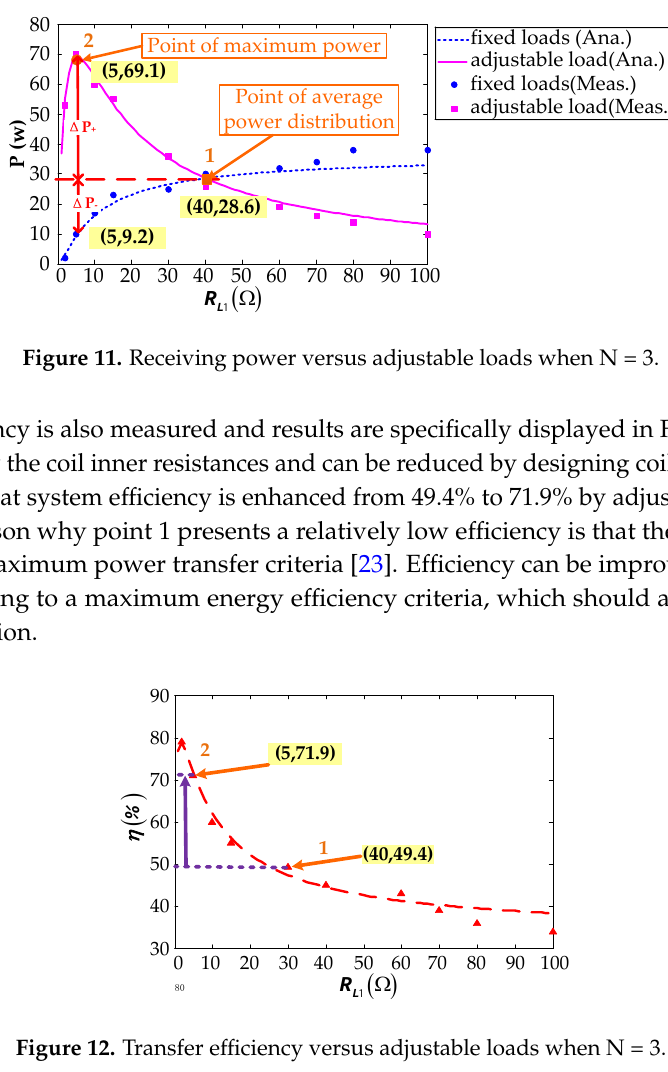
Figure 12. Transfer efficiency versus adjustable loads when N = 3.